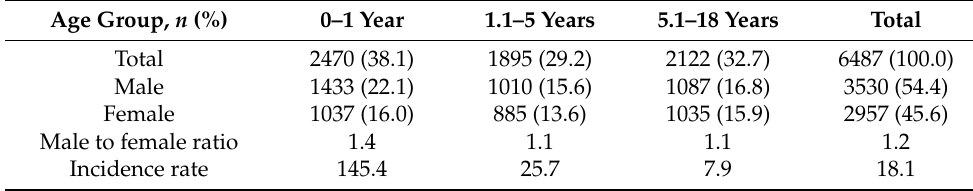
Table 1. Characteristics of